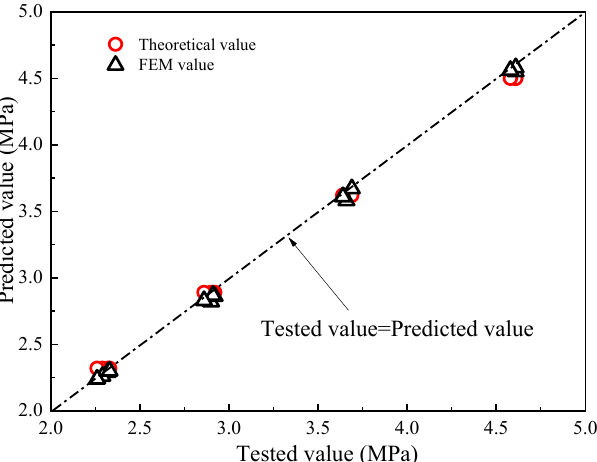
Figure 20. Correlation between predicted value and measured value. Root mean square error ( RMSE ), mean absolute error ( MAE ), maximum error ( ME ), and correlation coefficient ( R 2 ) were chosen as the model’s predictive ability evaluation indicators to verify the performance of the ASSY burst pressure prediction model pro- posed in this paper.